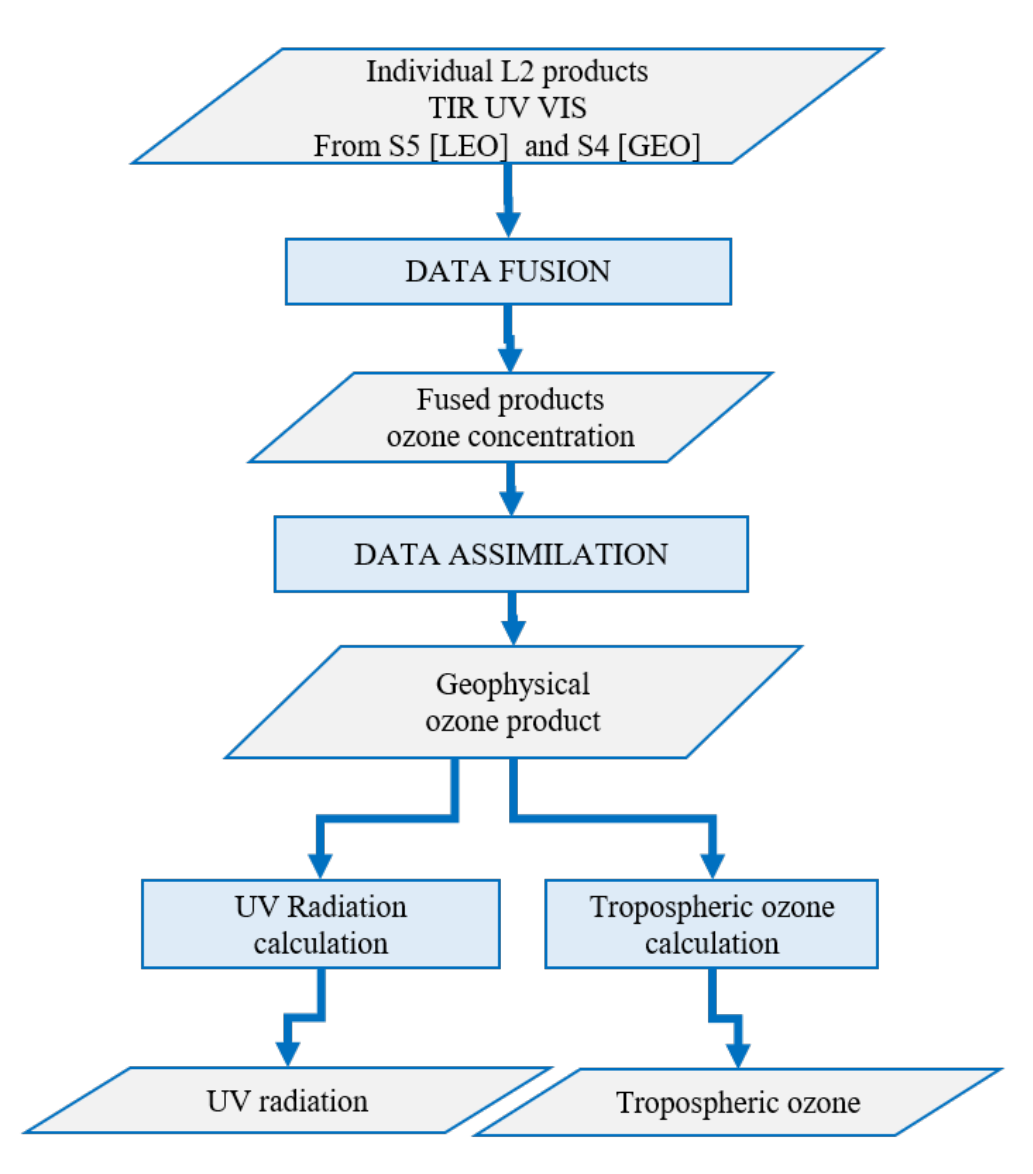
Figure 2. Flow diagram for the logic flow of the data